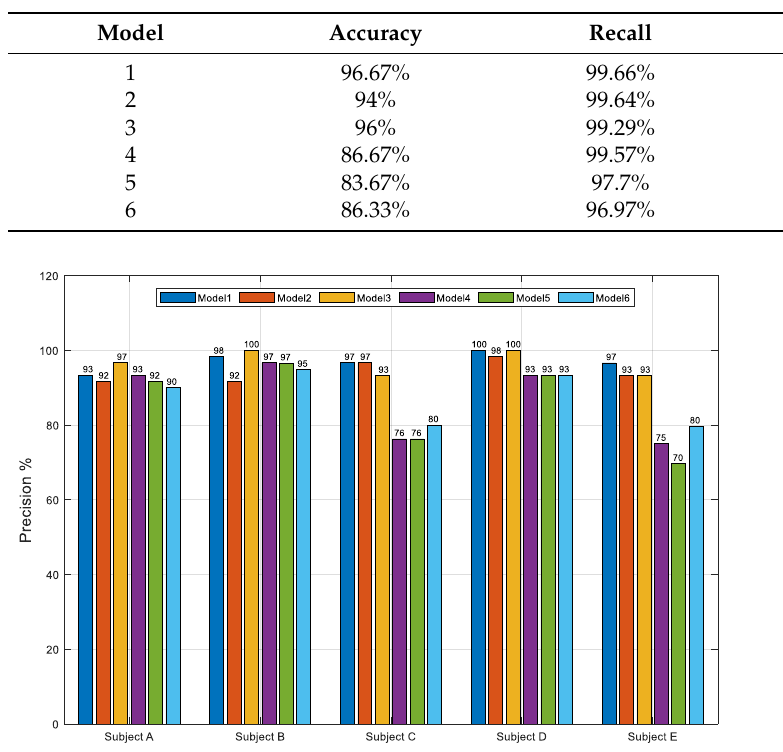
Figure 6. Average precision percentages over five subjects with six models.